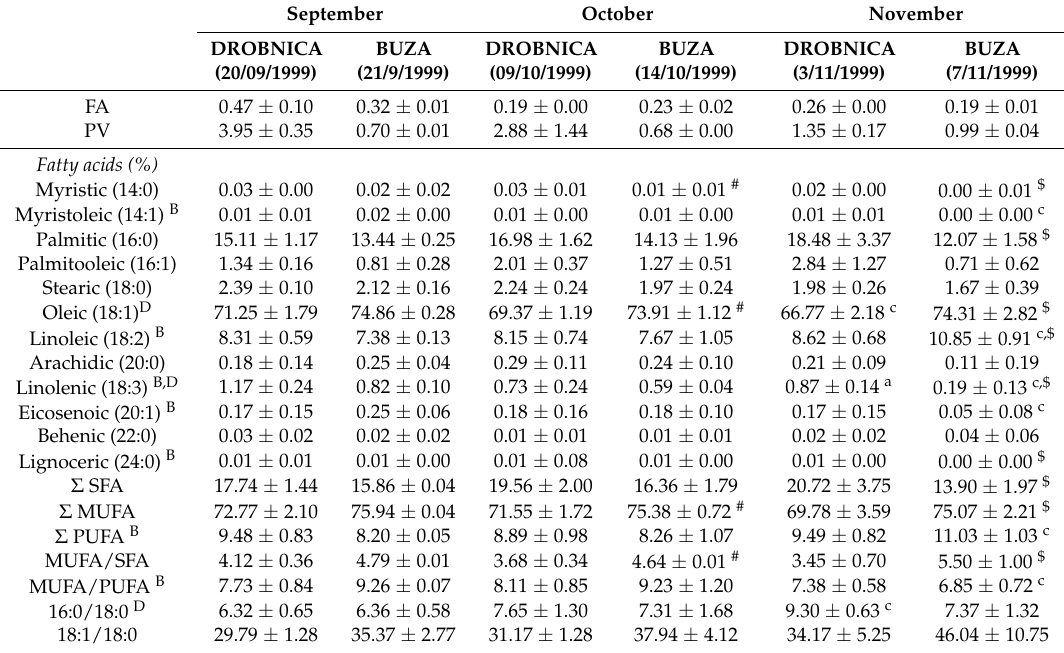
Table 2. Quality parameters and fatty acid composition (%) at various ripening stages of Drobnica and